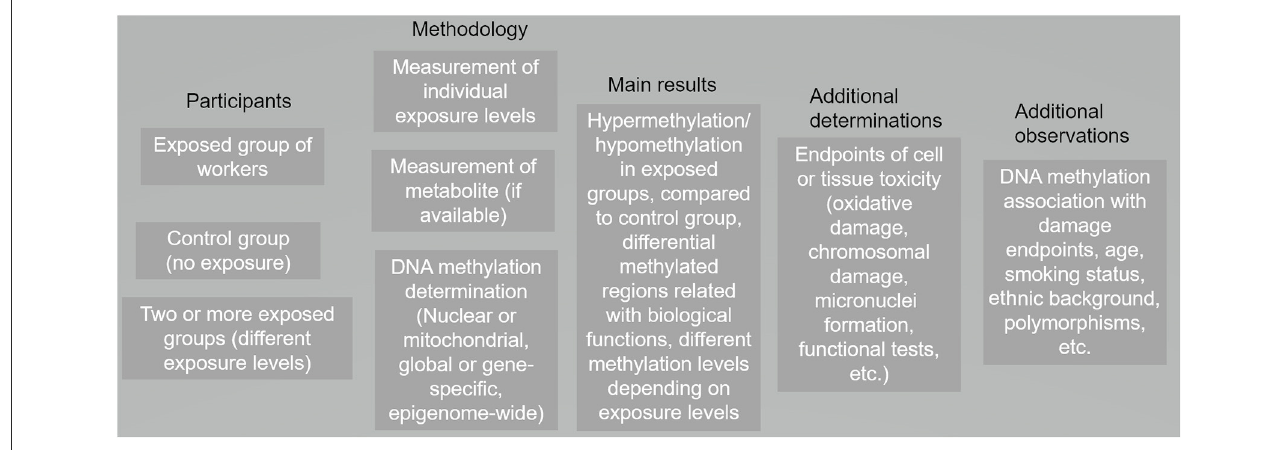
FIGURE1 Panorama of the general design and results in toxicomethylomics studies in blood cells from occupationally–exposed individuals published from 2007 to 2022 (116 research papers).